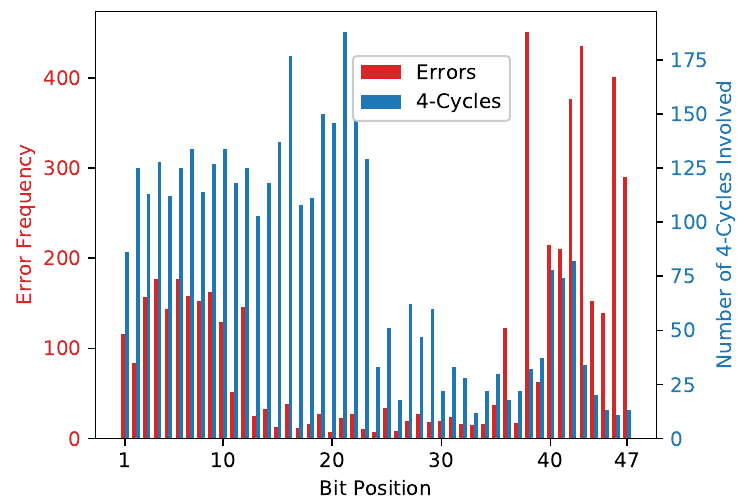
Figure 5. Distribution of 4-cycles and errors of the (47,24) QR code.